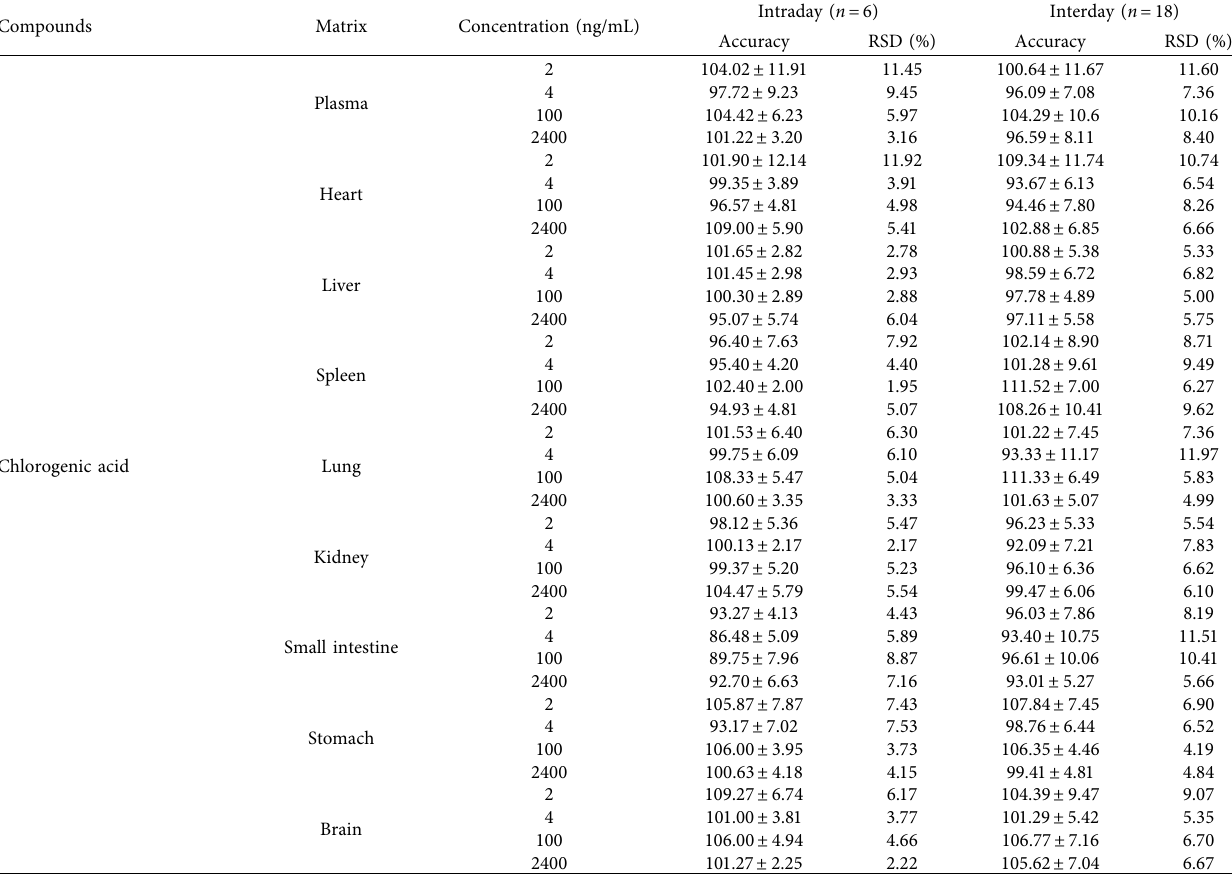
Table 3: Summary of intraday and interday precisions and accuracies of four analytes in plasma and tissue samples. Compounds